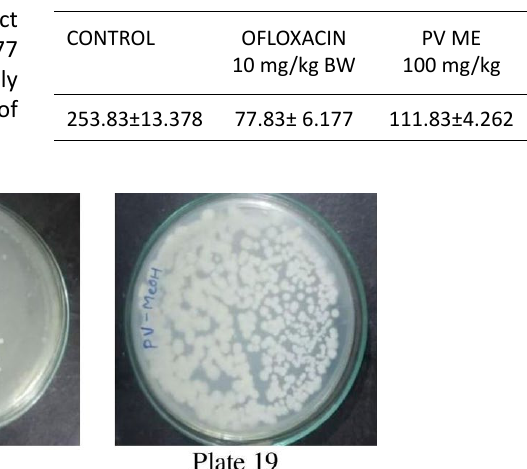
Table 2. Bacterial clearance study